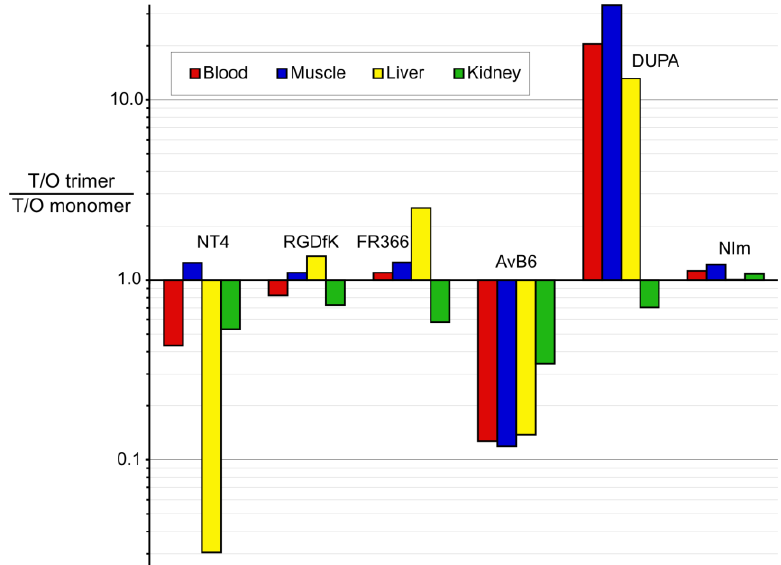
Figure 5. Quotients of tumor-to-organ ratios (T/O) of trimers and corresponding monomers, respectively, for compounds described in Table 3. Values above 1 indicate improvement upon trimerization, while values below 1 translate to deterioration.